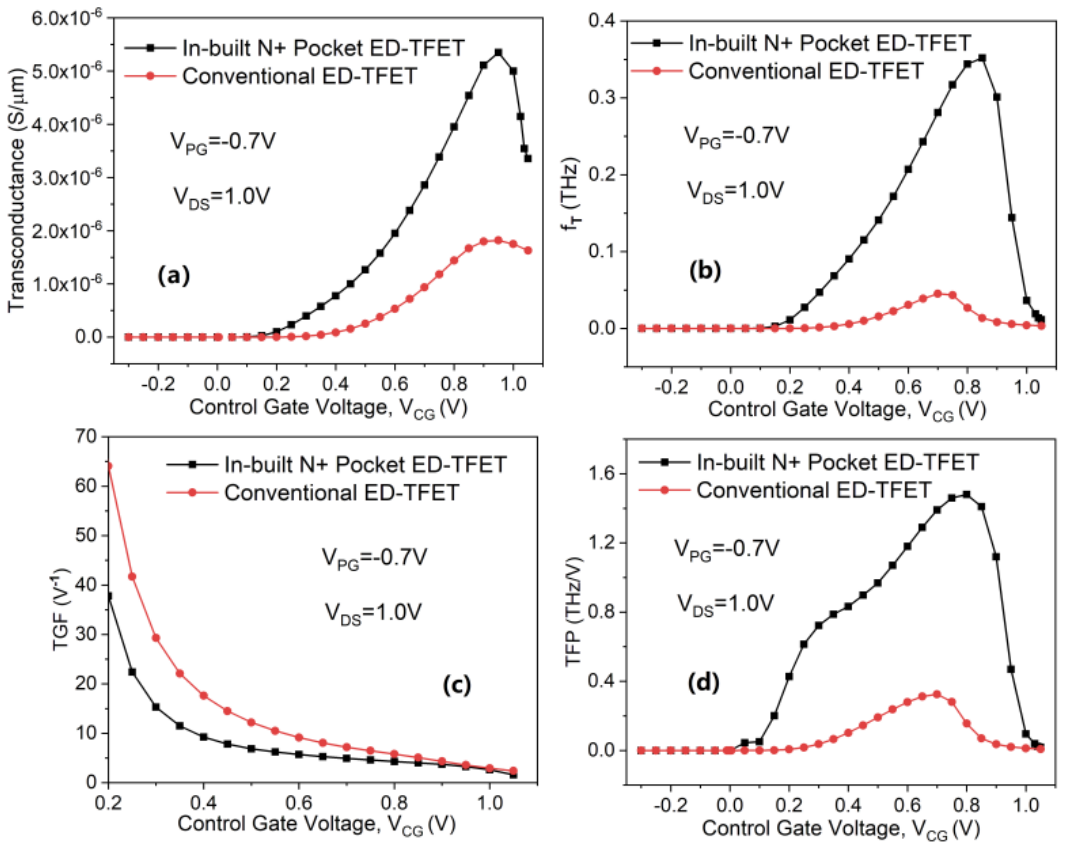
Figure 8. Variation of ( a ) transconductance, ( b ) cutoff frequency, ( c ) TGF, and ( d ) TFP along V CG of the conventional and in-built N + pocket ED-TFET.